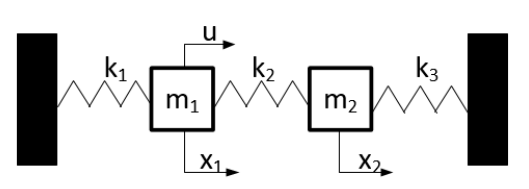
Figure 4. Reduced 2-DOF model of the SAS